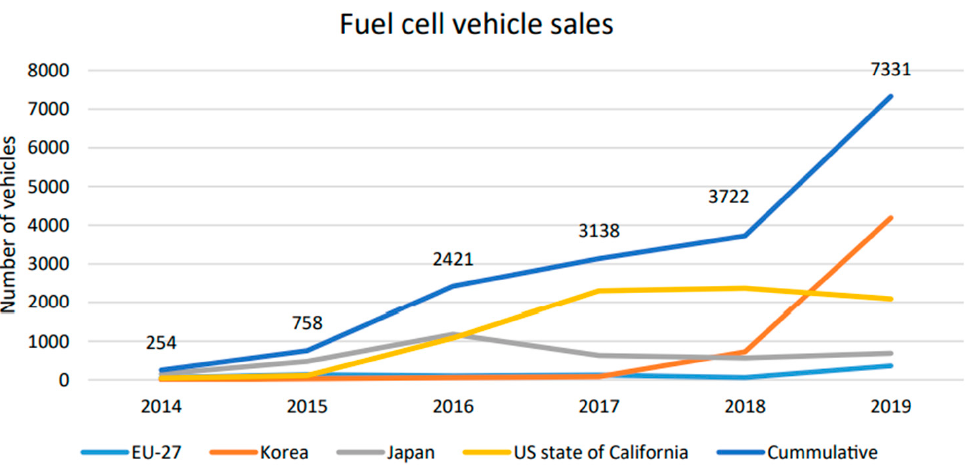
Figure 4. Global and cumulative annual sales of FCVs from 2014 to 2019 [18].